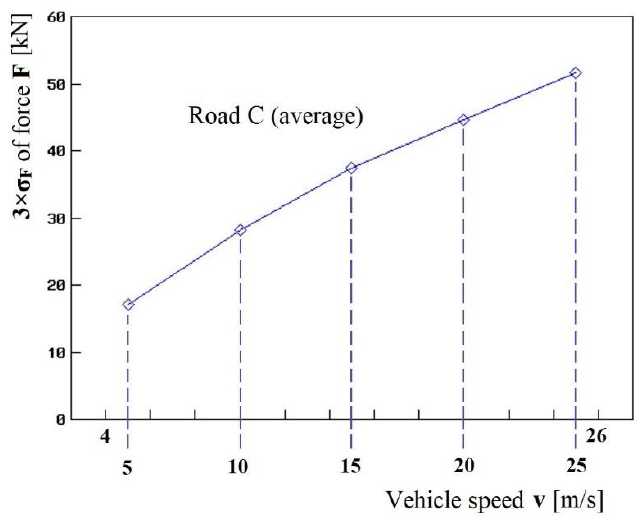
Figure 12. Values of 3 × σ F of the dynamic component of the vertical force F on the connection between the tractor’s fifth wheel and the semitrailer’s kingpin, for road C (average) and the five vehicle movement speeds v taken into account, i.e., 5 m/s, 10 m/s, 15 m/s, 20 m/s, and 25 m/s. There is a clear upward trend in the extreme value of the dynamic vertical force on increasing vehicle movement